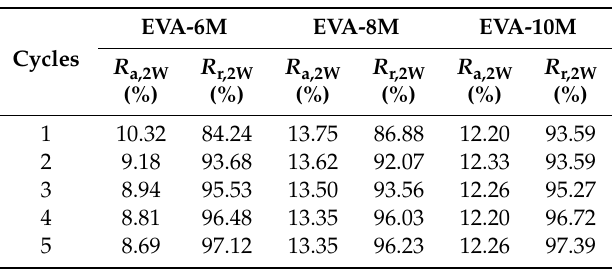
Table 3. 2W-SME of di ff erent EVA fiber under 0.27 MPa.